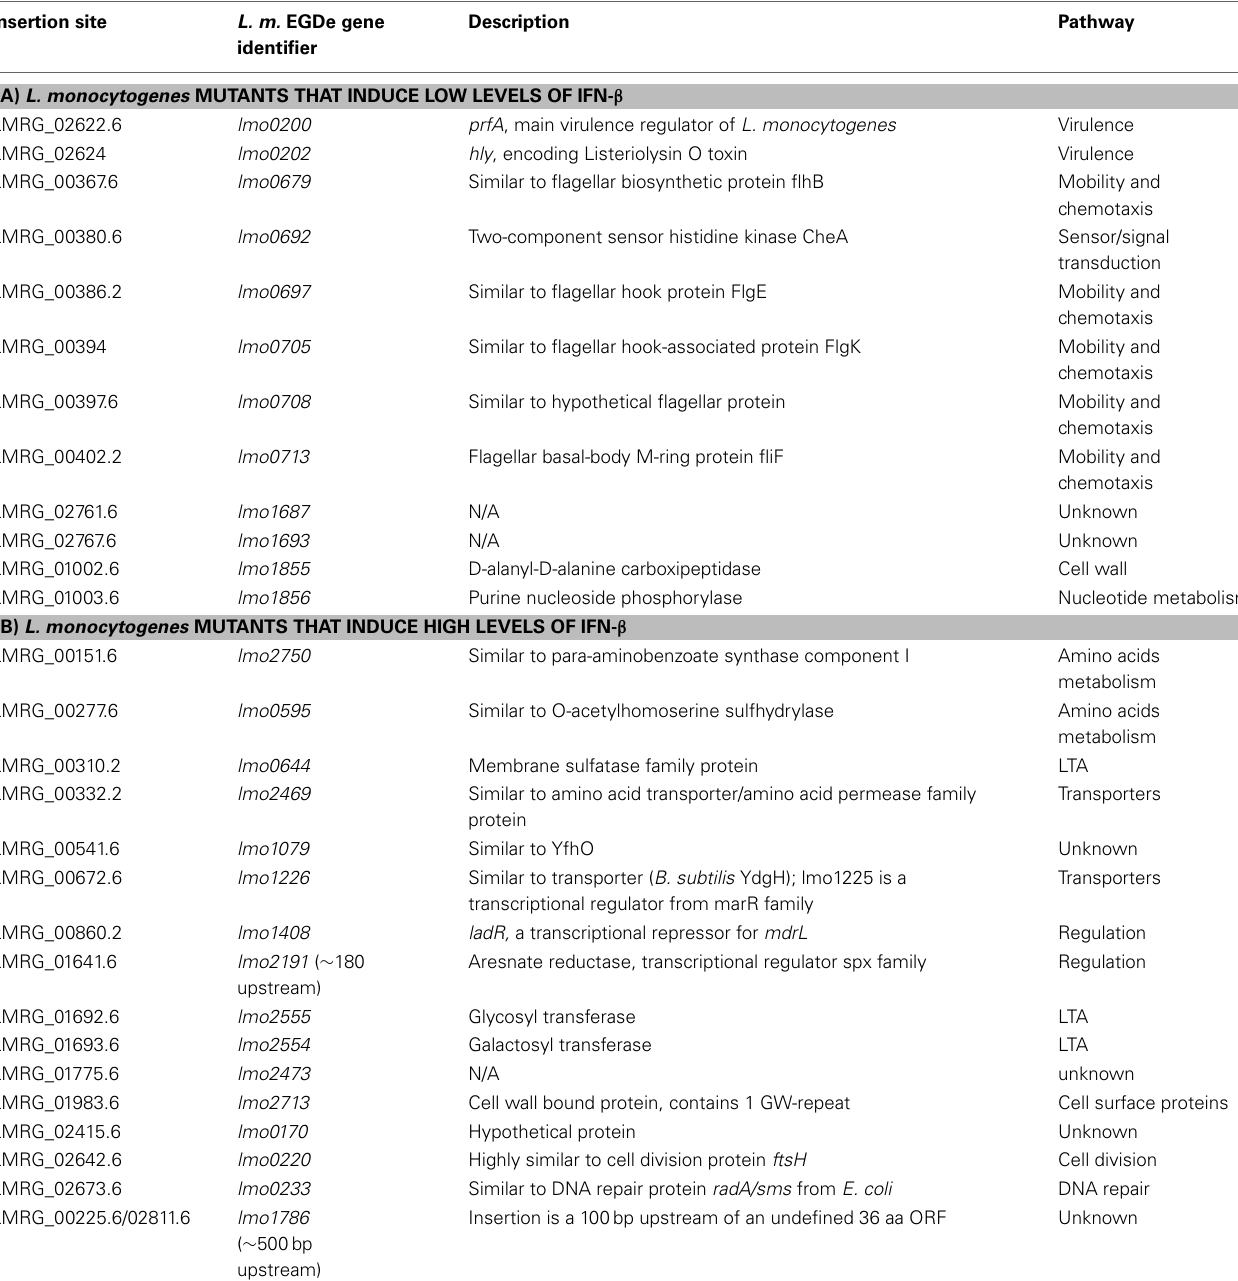
Table 1 | L. monocytogenes mutants that differentially activate IFN- β . Insertion